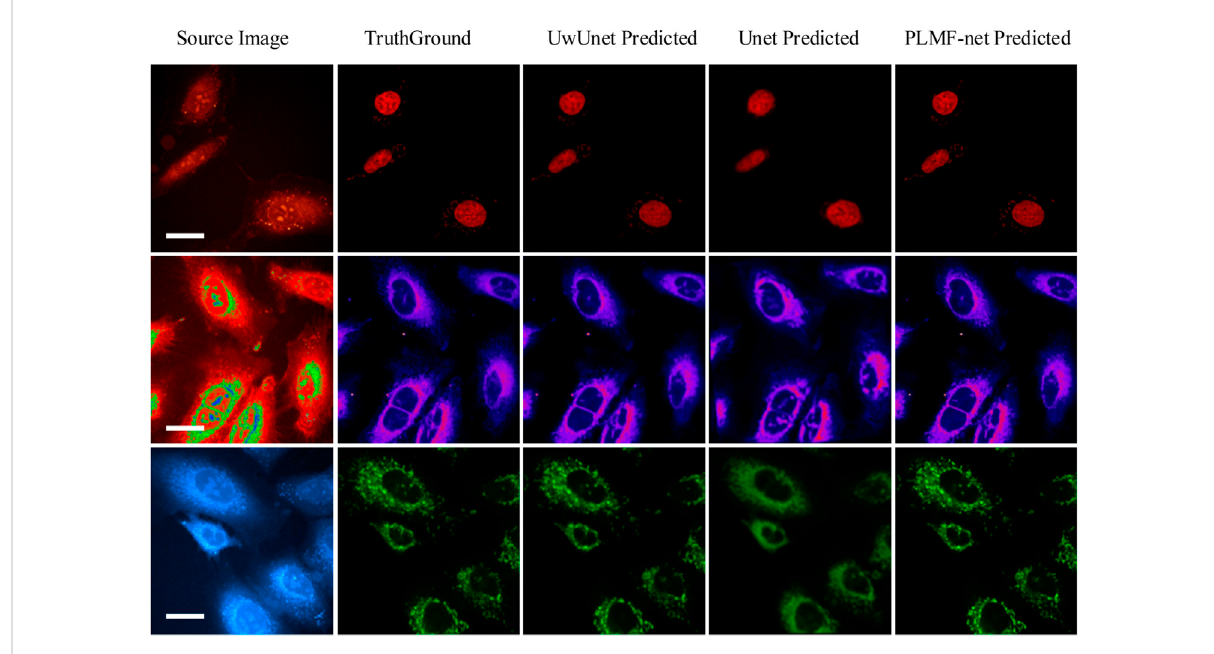
FIGURE 8 Predictedorganelle fl uorescencefromhyperspectralSRSmicroscopyimagesbyusingdifferentmethods.The fi rstcolumnshowstheinputSRS image, thesecondcolumnshows theground-truth fl uorescence image, and thefollowing threecolumns display thepredicted fl uorescence results by UwUNet, U-Net, and PLMF-Net, respectively, for nuclei (top row), mitochondria (middle row), and endoplasmic reticulum (bottom